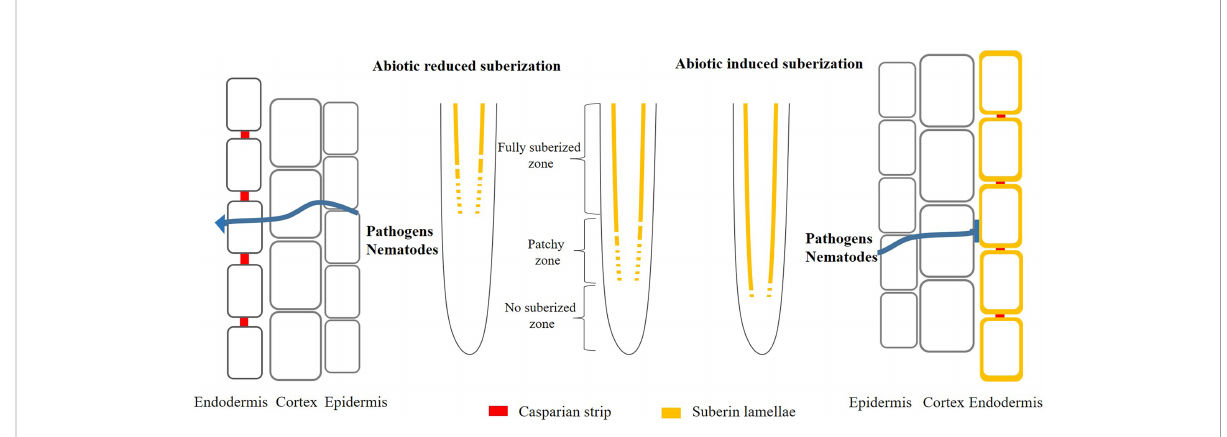
FIGURE 2 Model of abiotic induced/reduced suberization and its effect on pathogens and nematodes infection plants. Under normal conditions, plant roots deposit suberin in the endodermis. However, once the plant is stimulated by extern environment (nutrient de fi ciency or toxicity), it will deposit more or less suberin in the endodermis, thus protecting the plant from extern damage. Simultaneously, the change of suberization probably promote (decreased suberin) or prevent (enhanced suberin) the entry of pathogens and nematodes into the